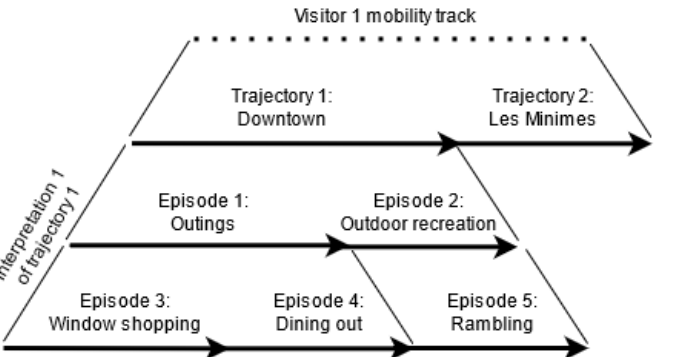
Figure 7. Example of a trajectory interpretation.